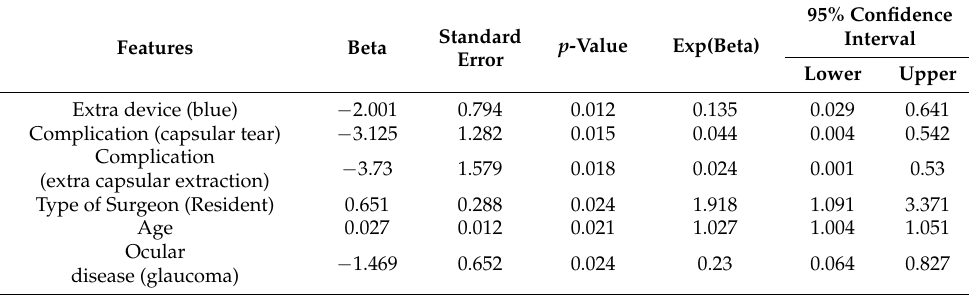
Table 6. Efficiency for the top 10 results and standard deviation of the mean. The entities are the following: no complications (NC), posterior capsular opacification (PCO), clinical macular oedema (CMO), long lasting corneal oedema solved without surgery (CE), pseudo-phakic bullous keratopathy (PBK), transient elevated intraocular pressure (EIOP), partial iris atrophy (PIA) intraocular lens decentration and/or dislocation (LD) and unsatisfactory visual recovery after cataract surgery (UVR). Individual Disease Entities NC PCO CMO CE PBK UVR Efficiency for the top 10 results and standard deviation of the mean 88.4 ± 16.7 On the other hand, “Extra devices used during surgery (blue)”, “Ocular diseases (glaucoma)”, “complication which occurred during surgery (Capsular Tear and Extra Capsular extraction)”, “Type of surgeon”, “Patient age”, and “Ocular Disease (Glaucoma)” were identified as significant factors in multivariate logistic regression model (Table 7). Table 7. Results of the multivariate logistic regression analysis.